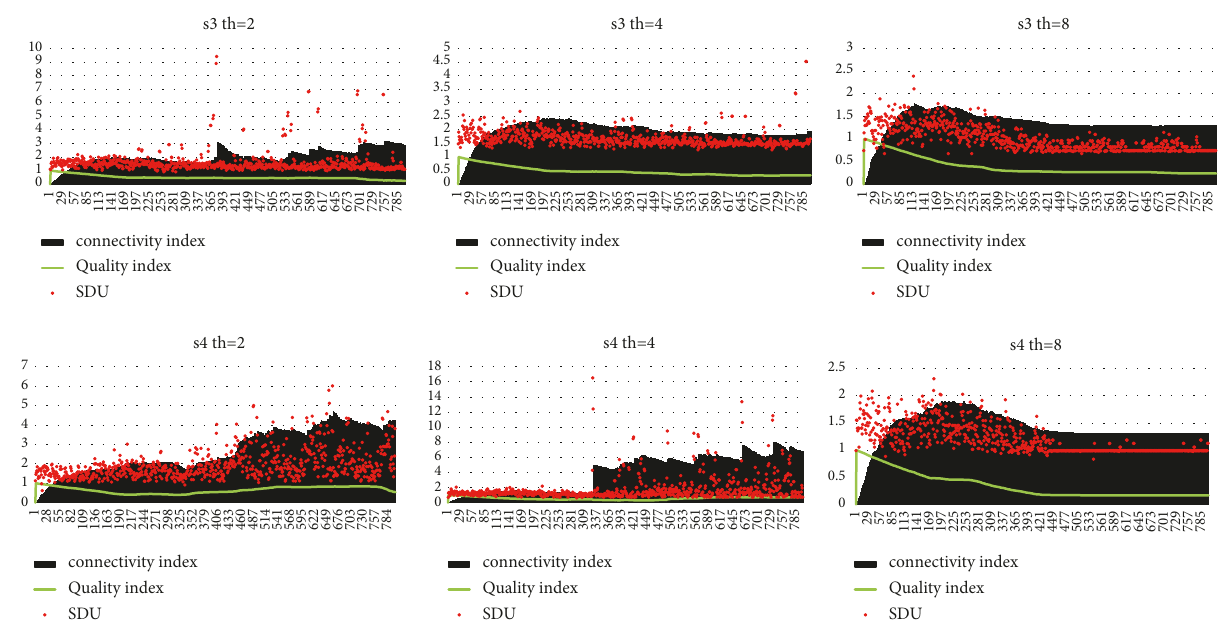
Figure 7: Phase shift analysis. Each graph above shows a time-series plot of 800 hours. Quality index is shown through green line. The SDU is shown through red points, and quality index is shown through bars fillings in black. The first row is of s1, followed by s2. The columns represent 𝑡ℎ 𝑠𝑡𝑟𝑜𝑛𝑔−𝑡𝑖𝑒 = 2 (column 1), 𝑡ℎ 𝑠𝑡𝑟𝑜𝑛𝑔−𝑡𝑖𝑒 = 4 (column 2), and 𝑡ℎ 𝑠𝑡𝑟𝑜𝑛𝑔−𝑡𝑖𝑒 = 8 (column 3). These graphs correspond to 550 vehicles and 15 resources.